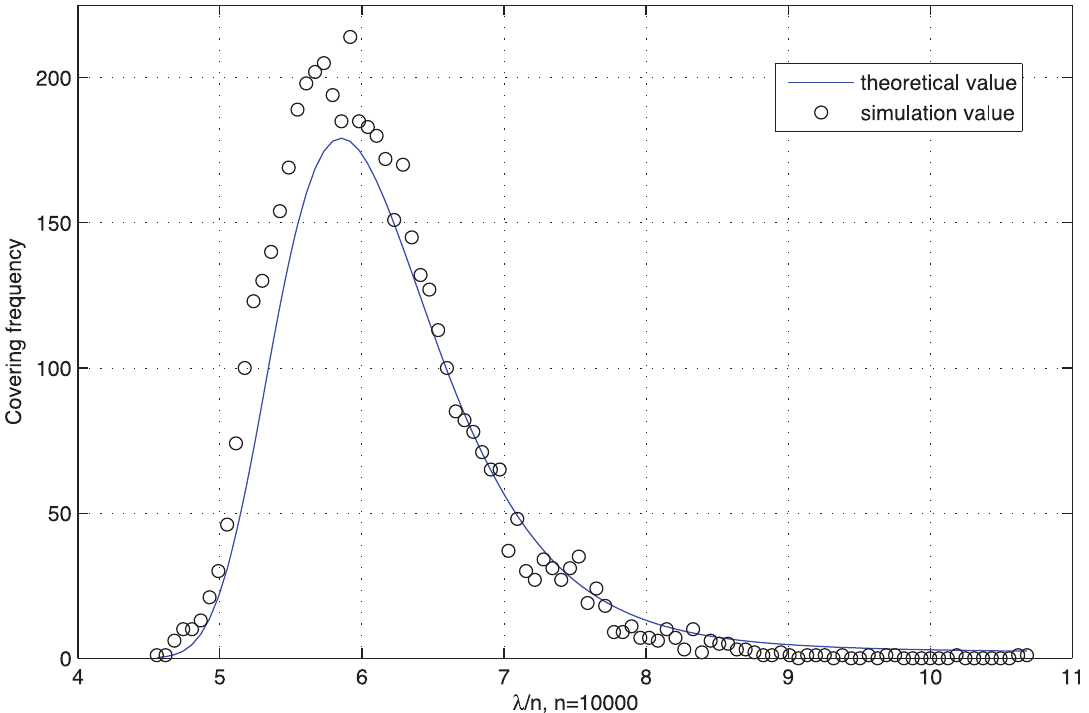
Figure 2. With network size n = 10000, the probability distribution to cover the address space. The theoretical probability distribution is calculated by formula (17) which is represented as a solid line, and the simulation result is pointed by little circles.